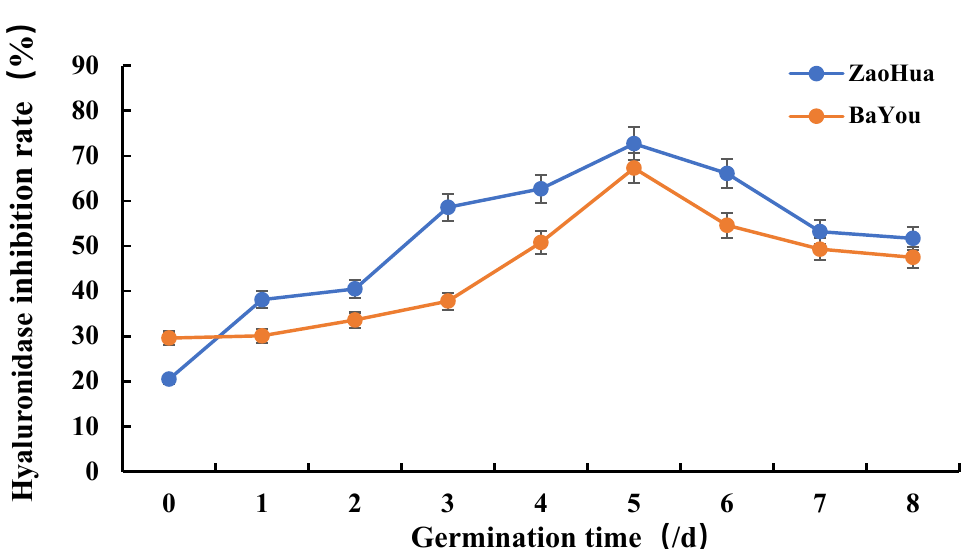
Figure 3. In vitro hyaluronidase-inhibition activities of the anthracamide (AVN) extract of the oats at different germination times.